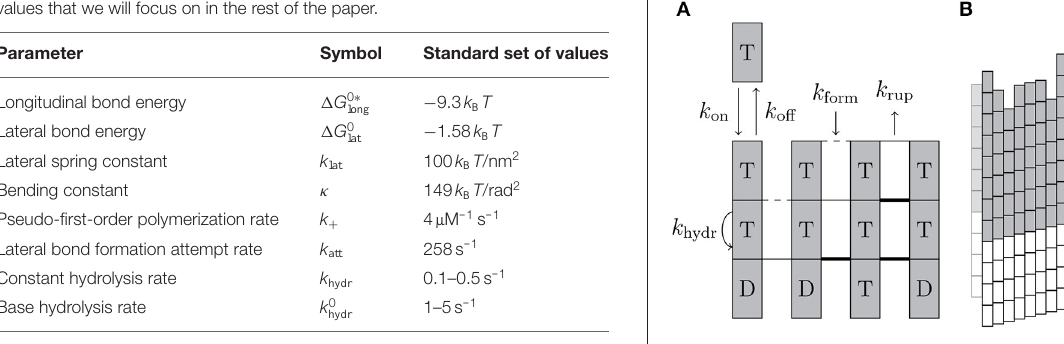
FIGURE 2 | (A) Schematic illustration of the different simulation events with their rates. Dashed lateral bonds can be formed with rate k form , thin solid lateral bonds can rupture with rate k rup , and thick bond cannot rupture. “T” and “D” correspond to the hydrolysis state of beta-tubulin of the dimers. (B) If the black tubulin dimer in layer d is affected by an event and d cutoff = 2 was used, all of the gray (and the black) tubulin dimers are used for energy